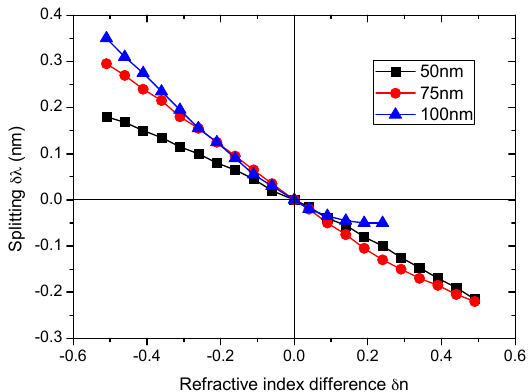
Figure 7. (Color online) Refractive index dependences of the splitting ( δλ = λ (cid:2924) − λ (cid:2911) ). The nanocylinder is embedded at (cid:1856) (cid:3030) = 4.75 μm .